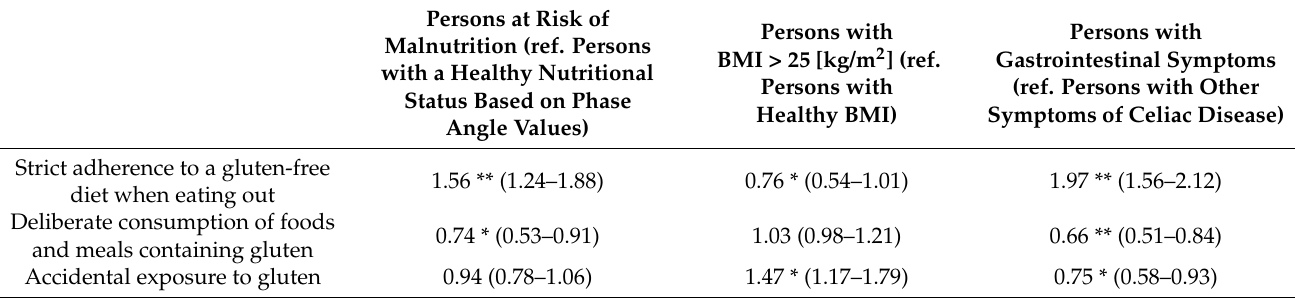
Table 5. Odds ratios (95% confidence interval) in an analysis of the relationships between nutritional status and adherence to a gluten-free diet among adults. Persons at Risk of Persons with Persons with Malnutrition (ref. Persons Gastrointestinal Symptoms BMI > 25 [kg/m 2 ] (ref. with a Healthy Nutritional (ref. Persons with Other Persons with Status Based on Phase Symptoms of Celiac Healthy BMI) Angle Values)